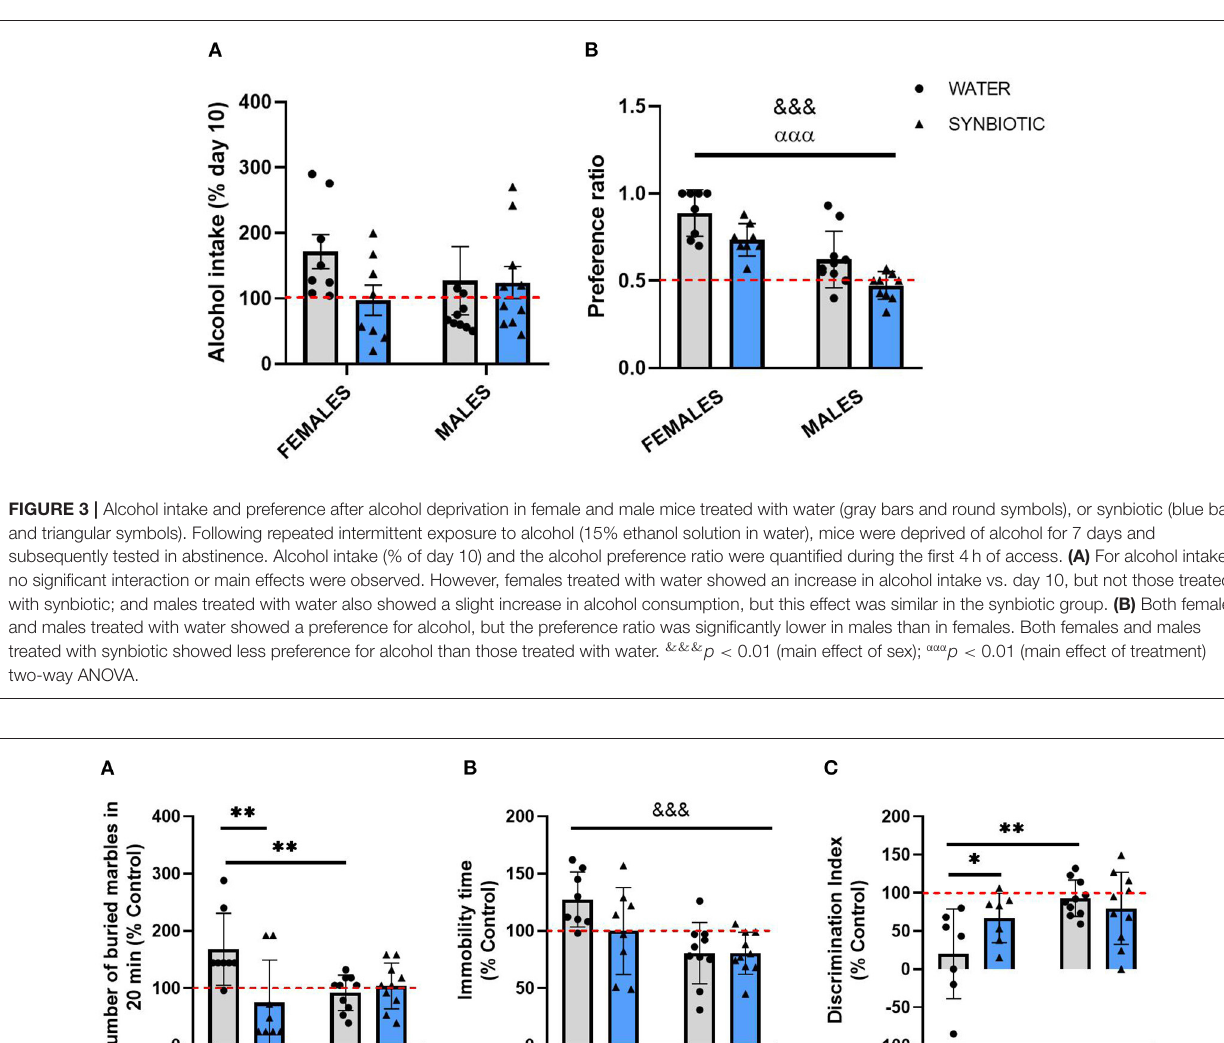
showed a significant alcohol effect [ F (1, 18) = 6.21, p < 0.05; F (1, 18) = 7.89, p < 0.05, respectively]. No significant effects were observed for OTU abundance in males ( Figure 5F